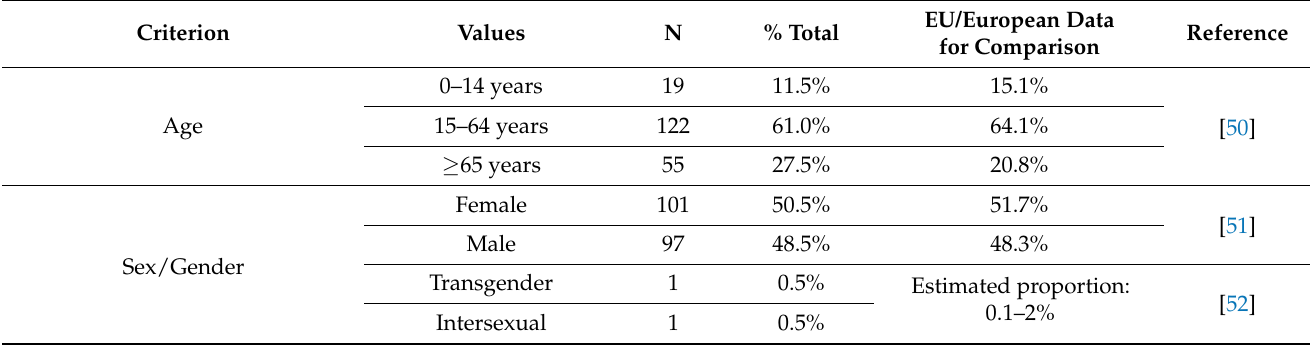
Table 2. Summary of patient-related criteria and their respective data for